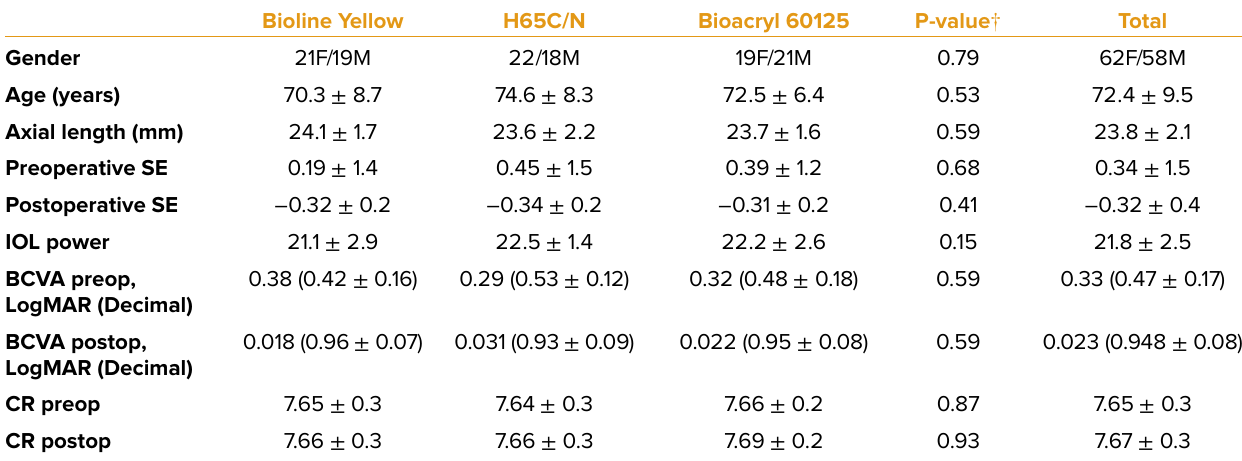
Table 2. Main demographics and clinical characteristics of the study